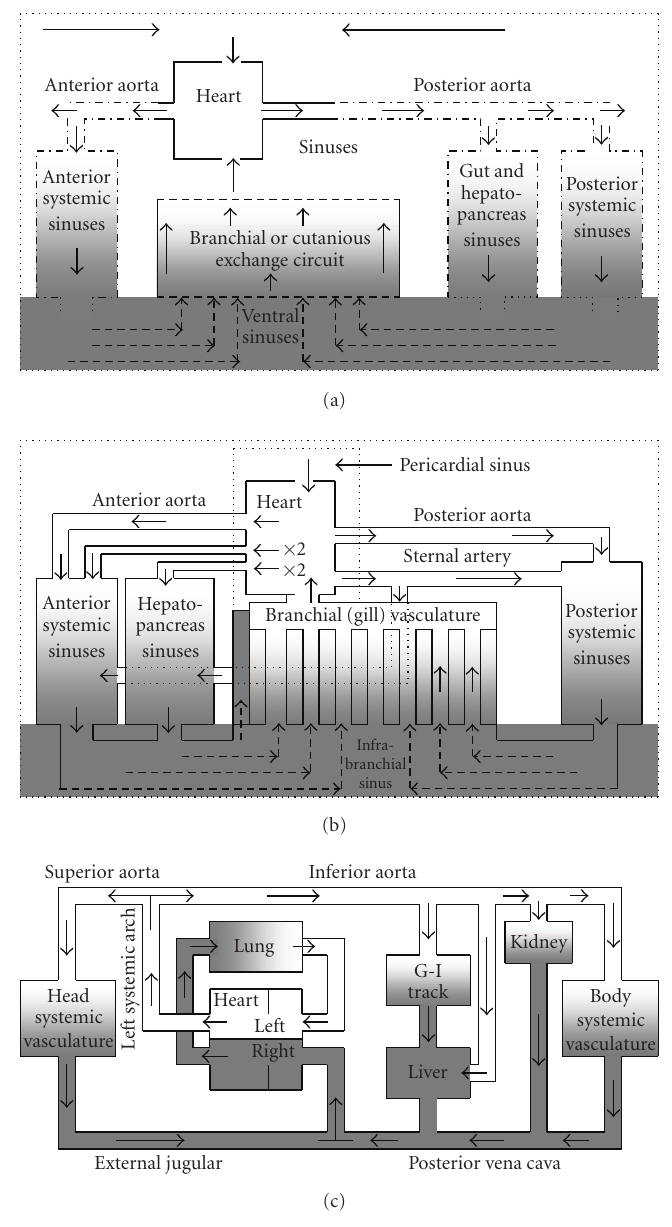
Figure 1: Schematics of: (a) a classically defined “open” circulatory system (as seen in may lower invertebrates), (b) a circulatory system that is highly complex with capillary like vessels, a partially lined vasculature yet contains vascular sinuses which classically has been defined as “open” yet should be categorized as an “incompletely closed” circulatory system. (c) A classically defined “closed” circulatory system (as seen in mammals and other higher vertebrates) ((c) adapted from Whithers [1]). (Solid lines represent defined vessels or a muscular pump or heart. Dashed lines represent sinus based systems and/or vessels lacking a defined lining. Arrows represent general patterns of blood flow. Background color is a general indicator of arterial versus venous hemolymph or